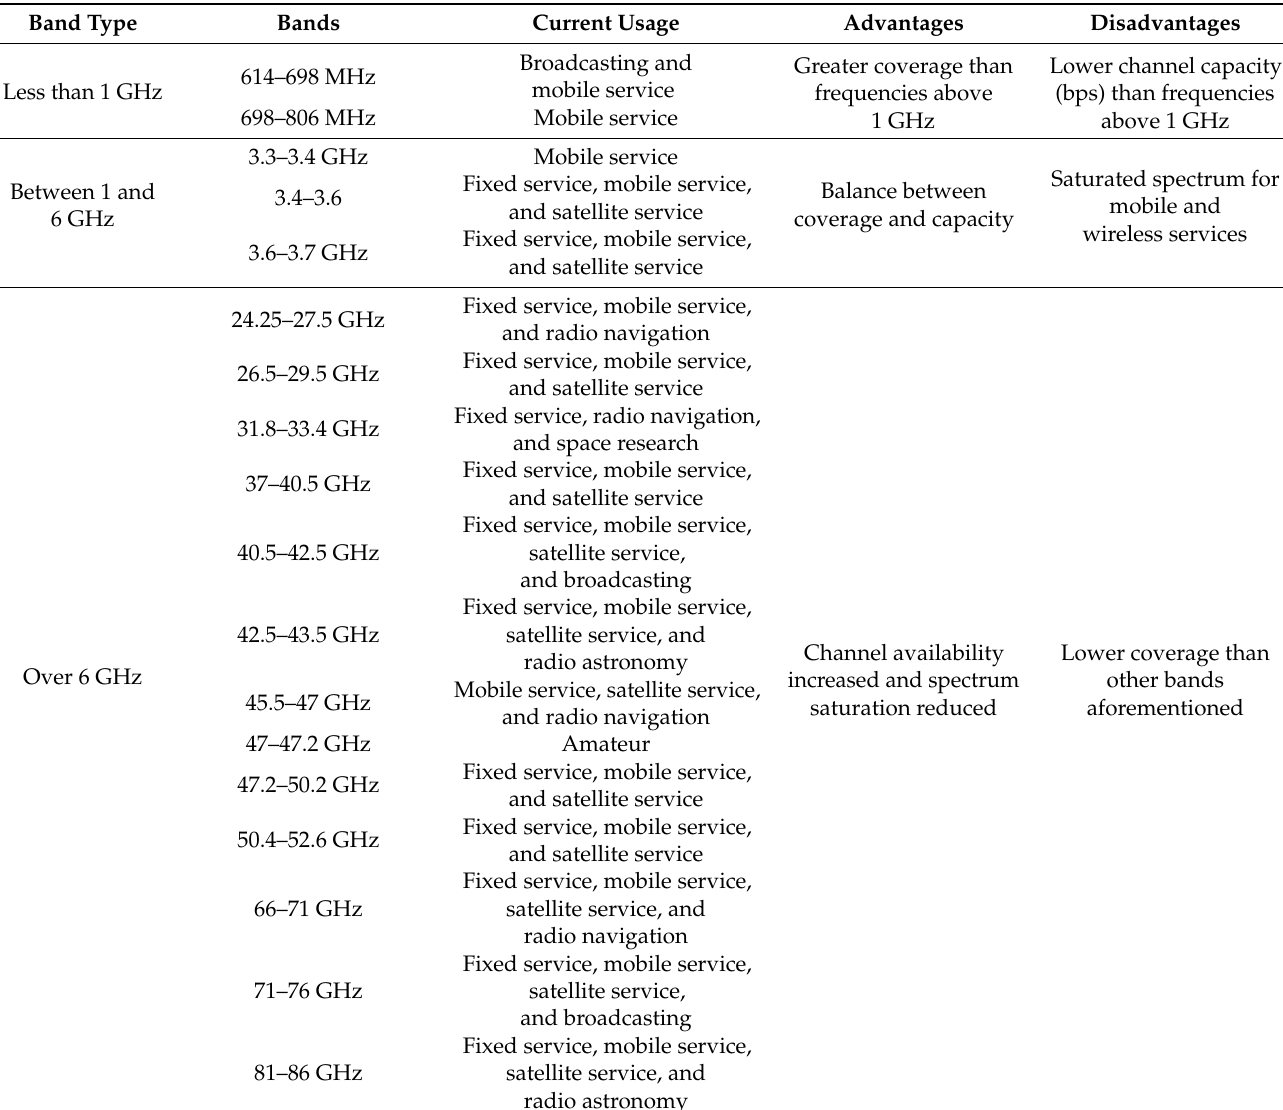
Table 3. General description of characteristics/typical requirements of IoT applications. Own elaboration based on information from MinICT and the National Spectrum Agency (ANE) and